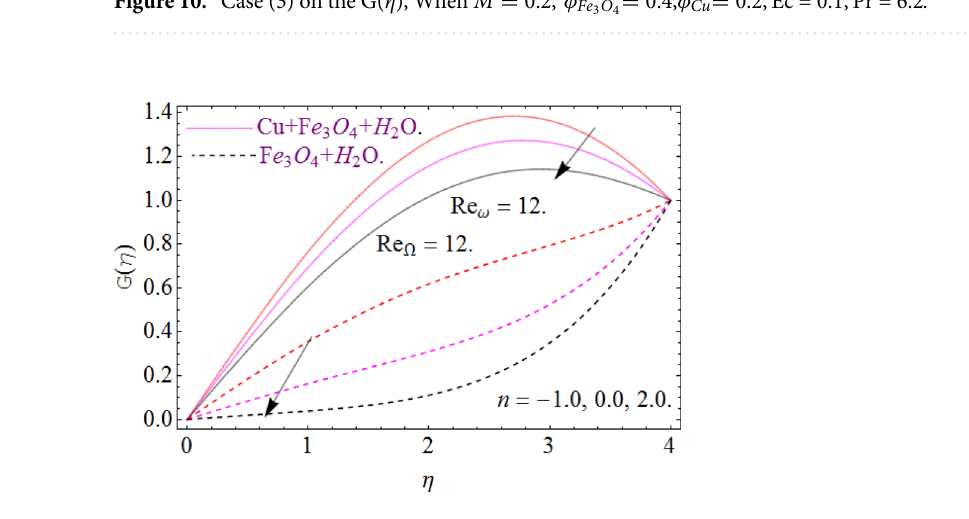
Figure 11. Case (4) on the G( η ), When M = 0.2, φ Fe 3 O 4 = 0.4, φ Cu = 0.2, Ec = 0.1, Pr = 6.2 .